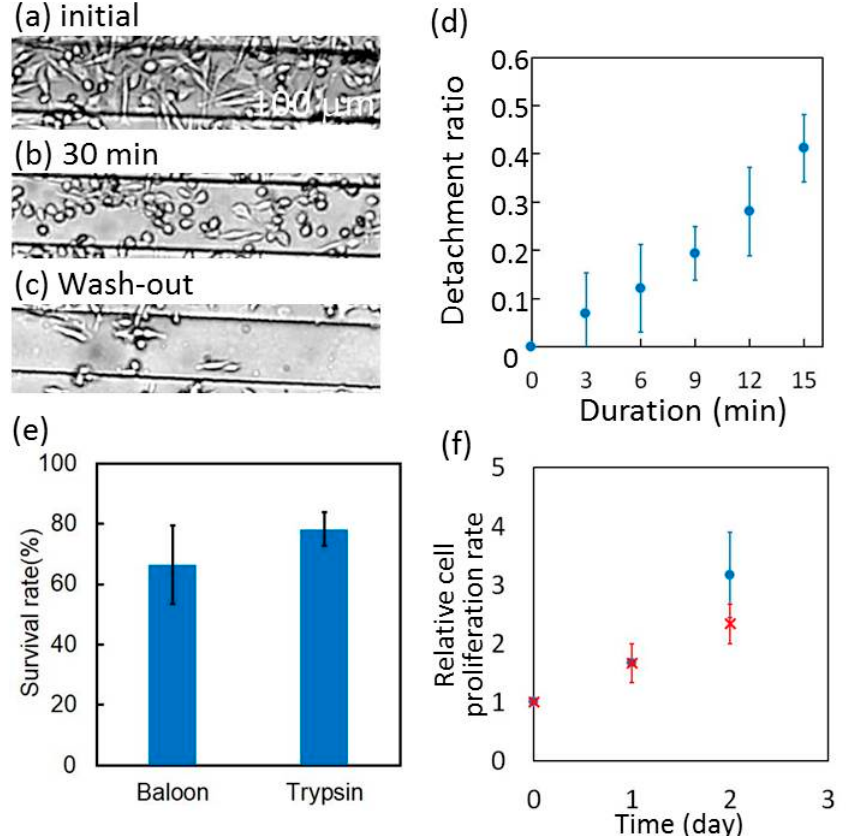
Figure 8. Cell detachment using balloon expansion. ( a ) Adhesive cells on balloon. ( b ) Detachment with the expansion of the balloon for 30 min in total. ( c ) Cells remaining after wash-out. ( d ) Cell detachment ratio as a function of duration of balloon expansion (n = 3. Error bar is standard deviation.). ( e ) Comparison of survival rate between cells detached by either the balloon or trypsin (n = 3. Error bar is standard deviation.). ( f ) Comparison of relative cell proliferation rates between cells detached by either the balloon or trypsin (n = 3. Error bar is standard deviation.).